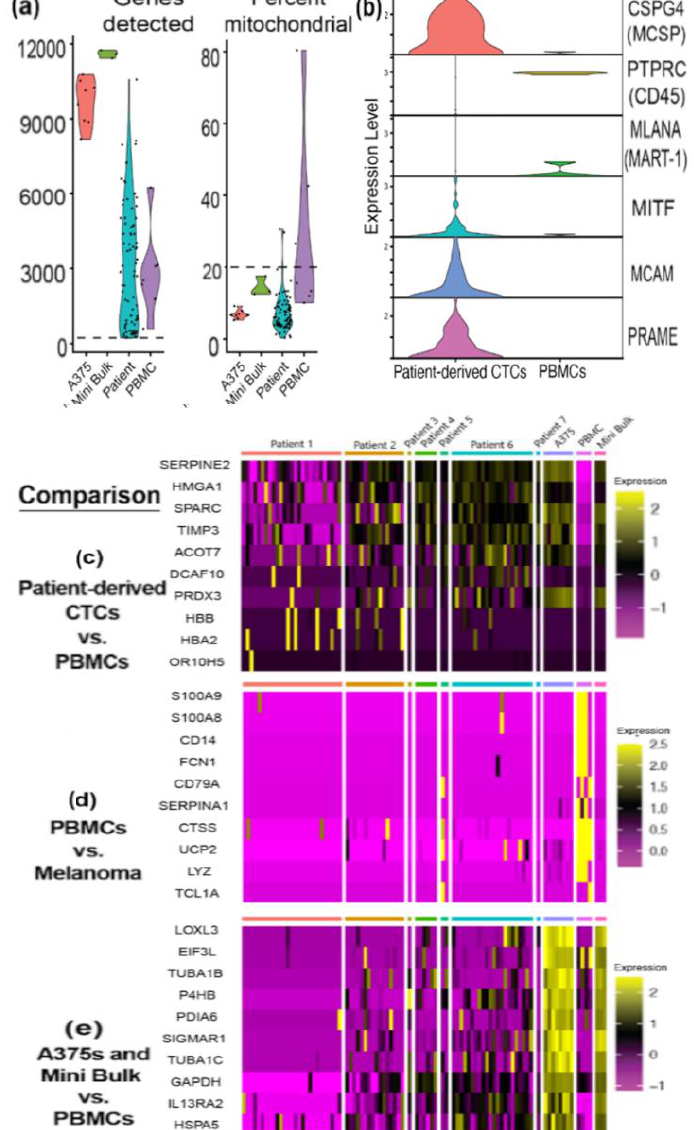
Figure 5. Melanoma CTCs are enriched for melanocytic gene expression by next-generation se- quencing analysis. ( a ) The number of unique genes detected (left) and percentage of mitochondrial transcripts detected (right) for single A375 cells, mini-bulk preps, patient-derived CTCs, and PBMCs. Dashed lines indicate QC cutoffs used to remove low-quality cells. ( b ) Violin plot demonstrating expression levels of melanocyte-specific genes ( CSPG4 (MCSP), MLANA (MART-1), MITF , MCAM , PRAME ), and PTPRC (CD45) in patient-derived CTCs compared to PBMCs. ( c – e ) Heat maps demon- strating the top 10 most differentially expressed genes when comparing ( b ) patient-derived CTCs to PBMCs, ( c ) PBMCs vs. all other cells (patient-derived CTCs, single A375s, mini bulk preps), and ( d ) library preps from cells grown in tissue culture (A375 single cells and mini bulk preps) vs. PBMCs. Expression levels are given as the log 2 fold change.